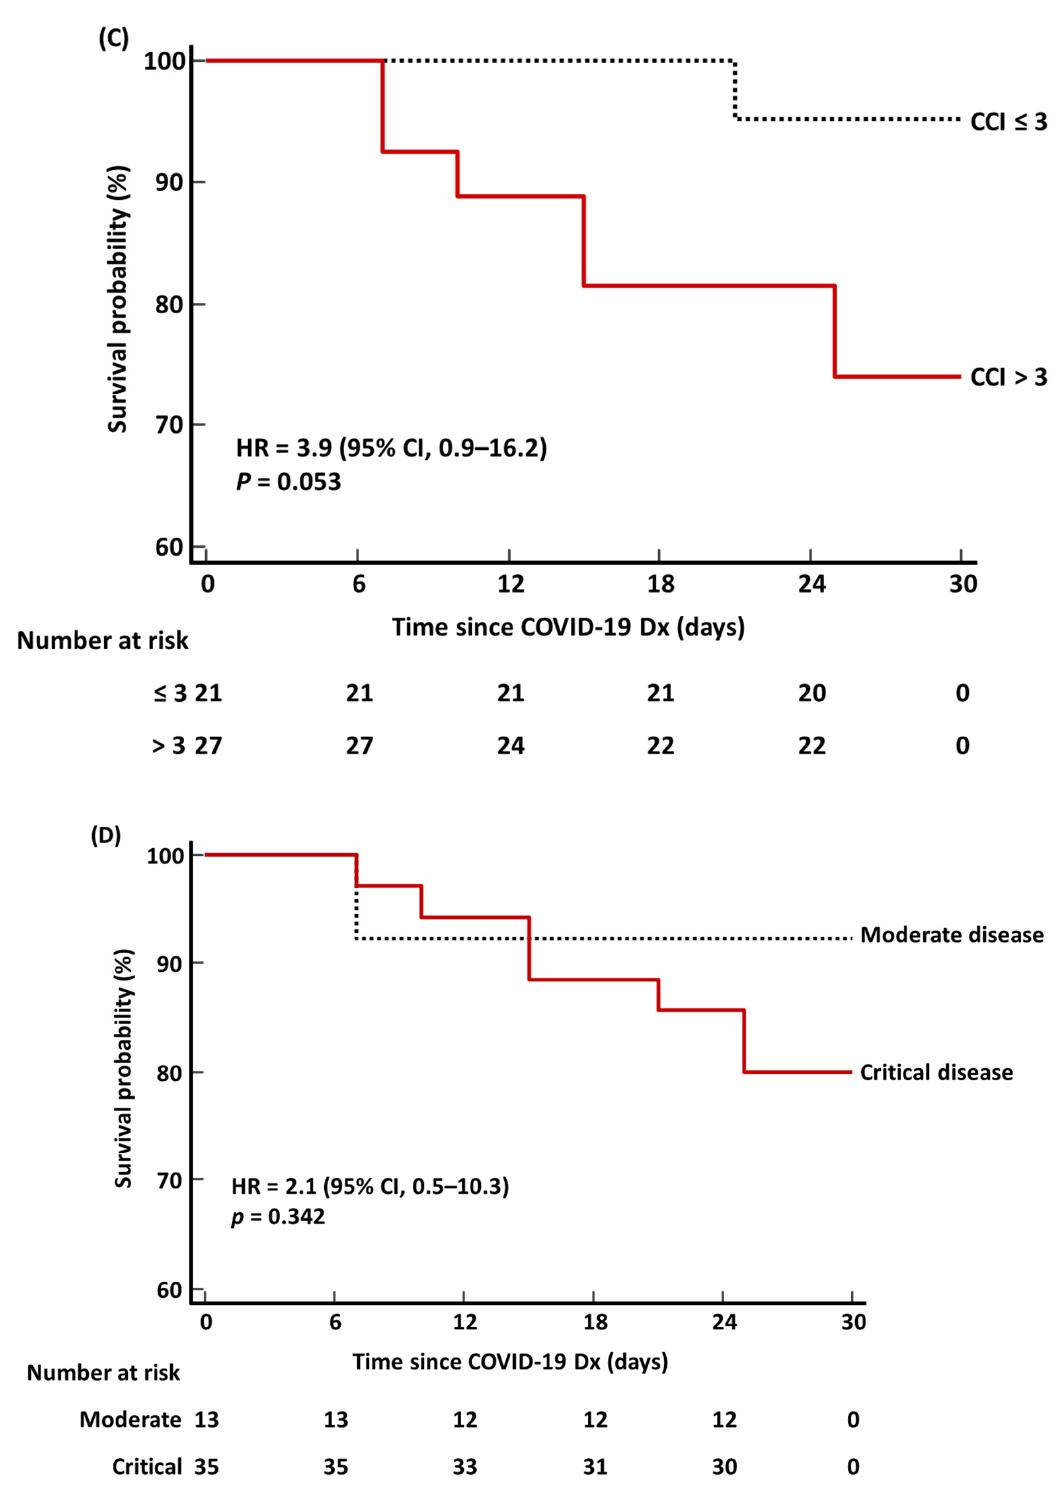
Figure 4. Kaplan–Meier survival analysis of age, initial KL-6 level, CCI, and critical disease for 30-day mortality. ( A ) Age. ( B ) Initial KL-6 level. ( C ) CCI. ( D ) Critical disease. Abbreviations: KL-6, Krebs von den Lungen-6; CCI, Charlson comorbidity index; HR, hazard ratio; CI, confidence interval; Dx,